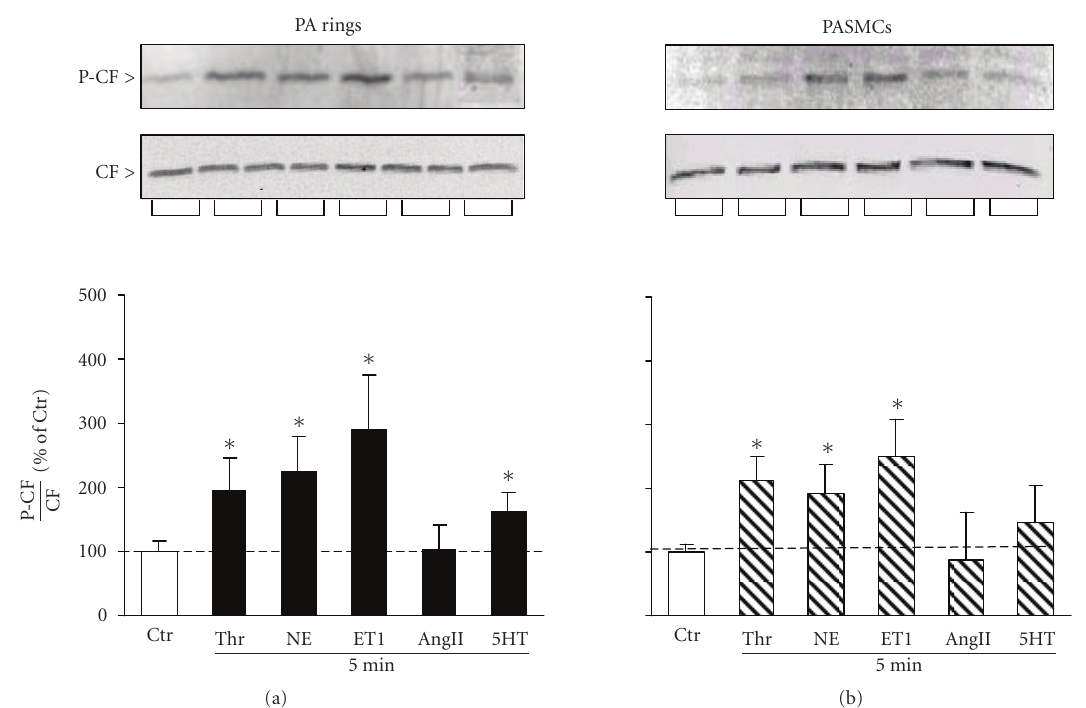
Figure 3: Contraction agonists stimulate cofilin phosphorylation in canine PA rings and cultured PASMCs. Freshly dissected PA rings and di ff erentiated PASMCs were incubated with thrombin (Thr), norepinephrine (NE), endothelin-1 (ET1), angiotensin II (AngII), and 5- hydroxytryptamine (5-HT) for 5minutes. Total protein was extracted and resolved by SDS-PAGE, and then transferred onto nitrocellulose. Membranes were probed simultaneously with CF and P-CF antibodies. Immunoreactive bands of P-CF were normalized to immunoreactive bands of CF (insets) and the agonist-induced changes in the P-CF/CF ratio were presented as percentage of untreated controls (Ctr, bar graphs). Mean ± SD, ( ∗ ) P < . 05 compared to untreated controls, n =